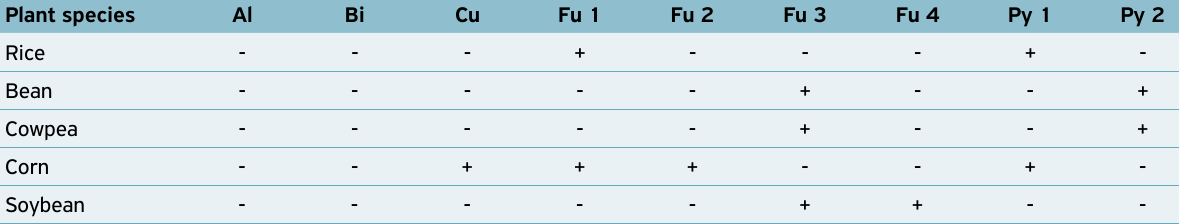
Table 3. Cross pathogenicity of fungi associated with weeds in cultivated plants.